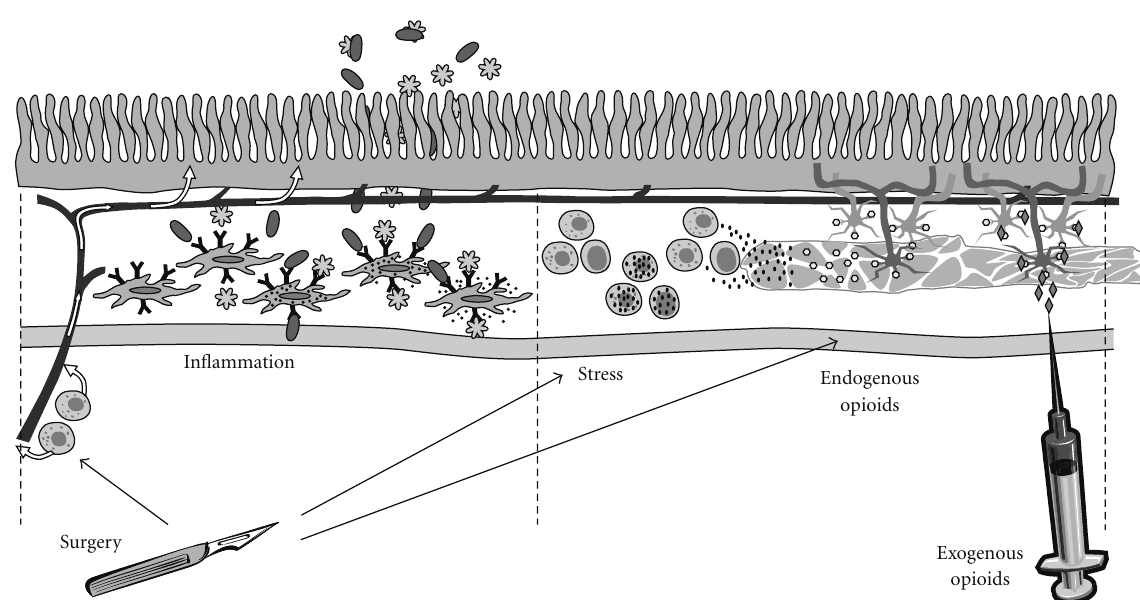
Figure 1: The multifactorial etiology of postoperative ileus (POI). Development of POI is multifactorial. Surgical incision and manipulation of the intestines activate inflammatory and stress responses and endogenous opioids. Mast cells release vasoactive substances di ff using into blood vessels. These substances increase mucosal permeability, allowing entrance of luminal bacteria or LPS into lymphatics or interaction with resident macrophages. Damaged tissue also activates macrophages, increasing expression of proinflammatory genes. Stress causes macrophages to release chemokines and inflammatory cytokines, which attract leukocytes to the intestinal muscularis. Large amounts of nitric oxide and prostaglandins are released, which impair smooth muscle contraction. Endogenous opioids are released, which disrupt GI transit and motility. Exogenous opioid analgesia also disrupts GI